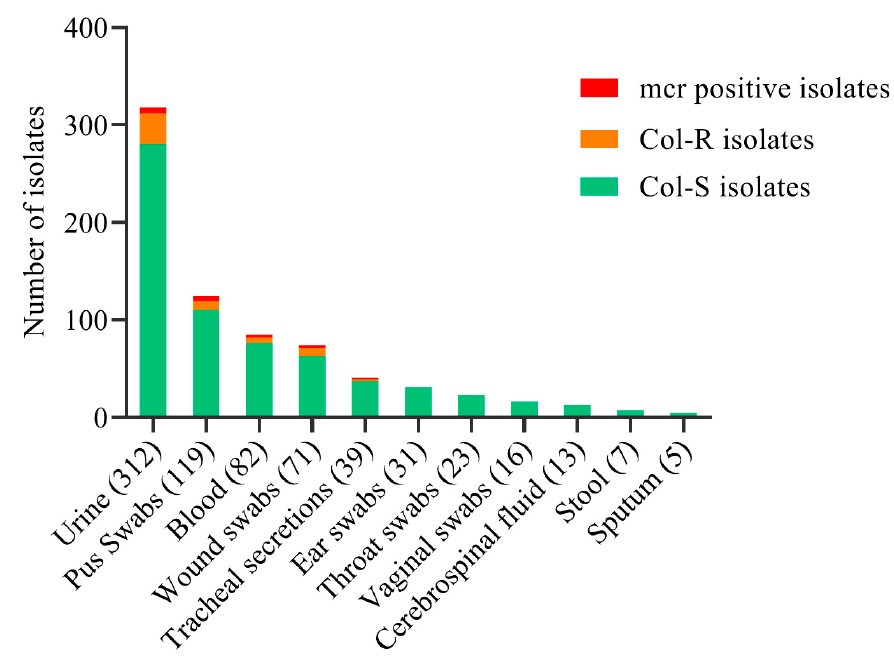
Figure 2. Distribution of colistin-sensitive (Col-S), colistin-resistant (Col-R), and mcr genes among the gram-negative bacterial strains isolated from various sources ( n = 718).